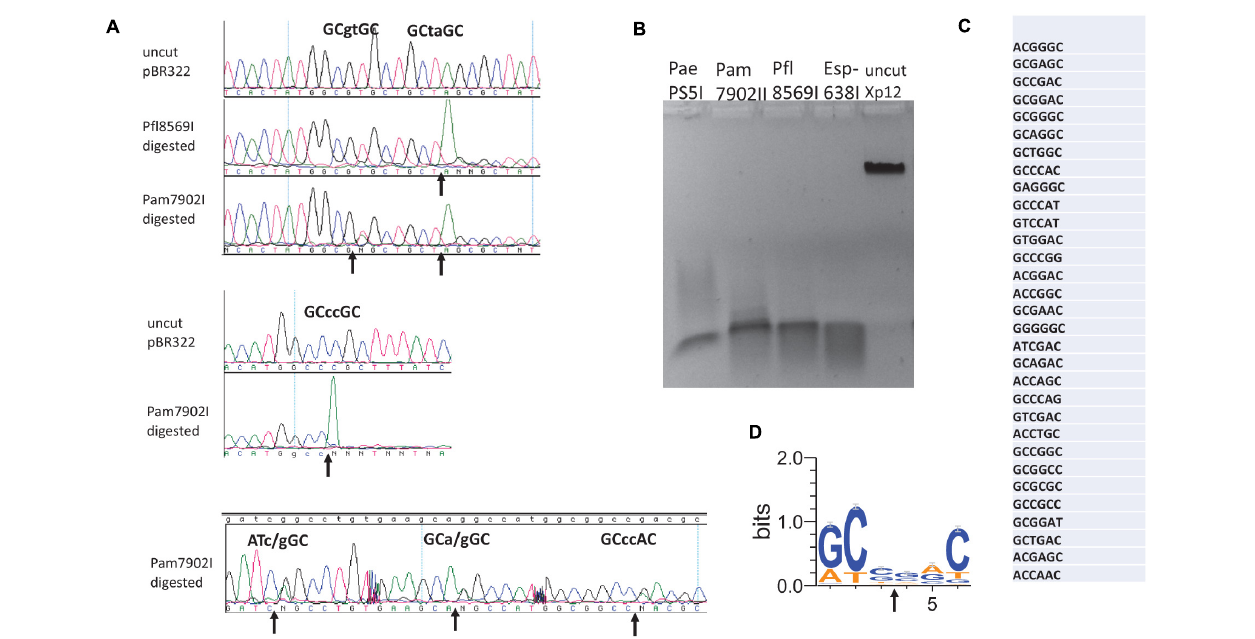
FIGURE 2 | Digestion of modified DNA substrates with Pam7902I and Pfl8569I, DNA run-off sequencing to determine the cleavage sites, and mapping Pam7902I consensus cut sites by Illumina sequencing. (A) Examples of cleavage sites by Pam7902I and Pfl8569I digestions and DNA run-off sequencing. The up arrows indicate the nicked template and the appearance of an extra adenine (A, shown in green color) peak after the nick by Taq DNA polymerase (i.e., addition of an adenine by the template-independent terminal DNA transferase activity). (B) Restriction digestion of Xp12 DNA (m5C) by PaePS50I, Pam7902I, Pfl8569I, and Esp638I. (C) Pam7902I restriction sites (including top 50% of the cleaved sites) digested by Pam7902I and subsequently found in the Illumina DNA library following restriction, library construction and sequencing. (D) Consensus DNA sequence (GCS ↓ SGC or relaxed sites RYS ↓ SRY) derived from all Pam7902I cleaved sites in Xp12 DNA (compiled by